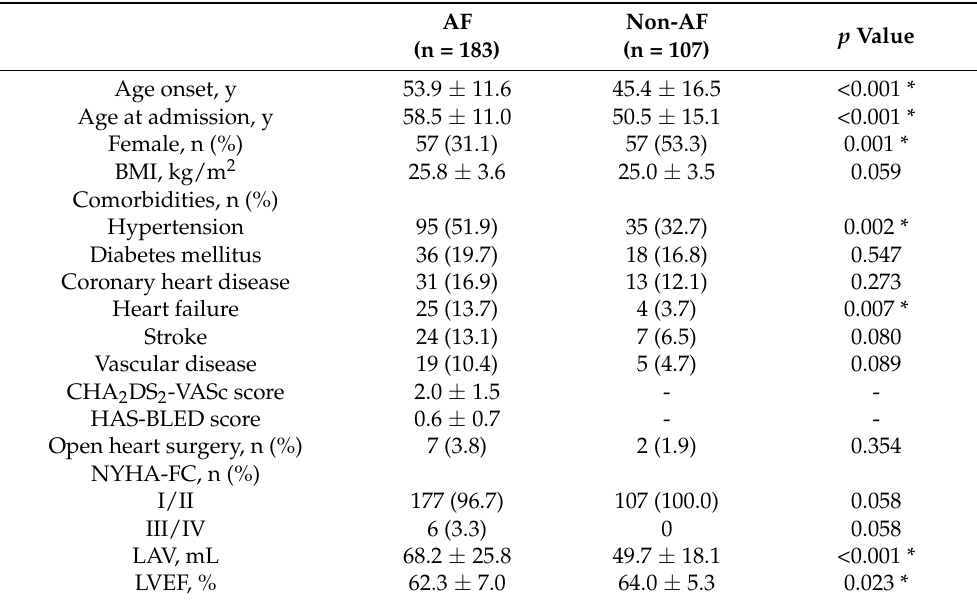
Table 1. Clinical characteristics of all patients.